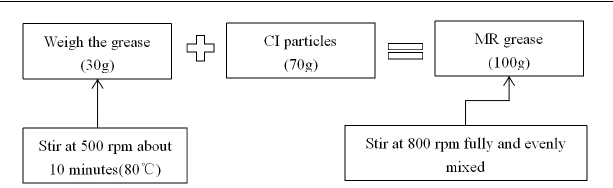
FIGURE 1 | Flow chart of preparation for